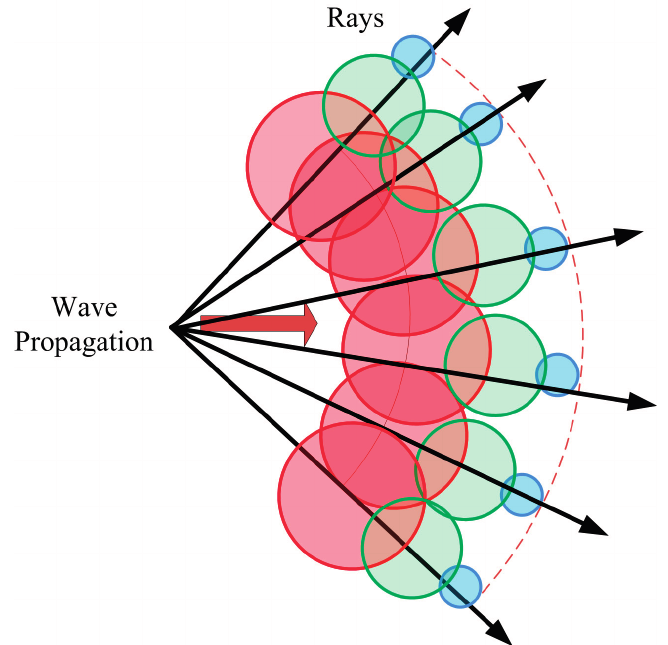
Figure 1. Wavefront propagation with rays associated with single wave front